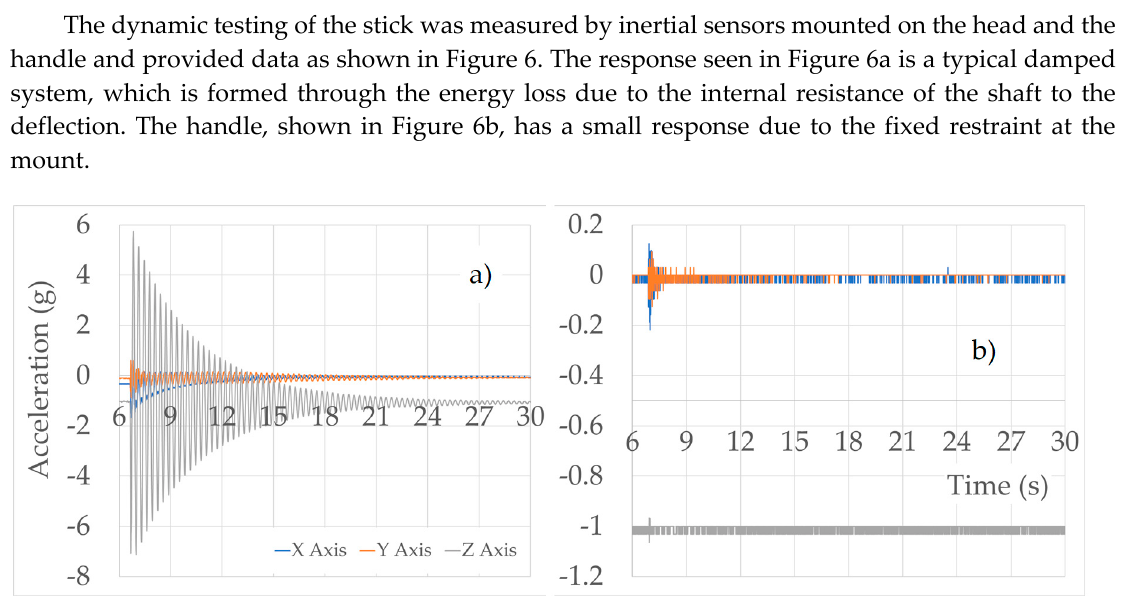
Figure 6. Data from inertial sensor taken showing damping characteristics of the stick at ( a ) the head and ( b ) the handle. Vertical motion is the Z-axis and horizontal motion is represented by the X- and Y-axis